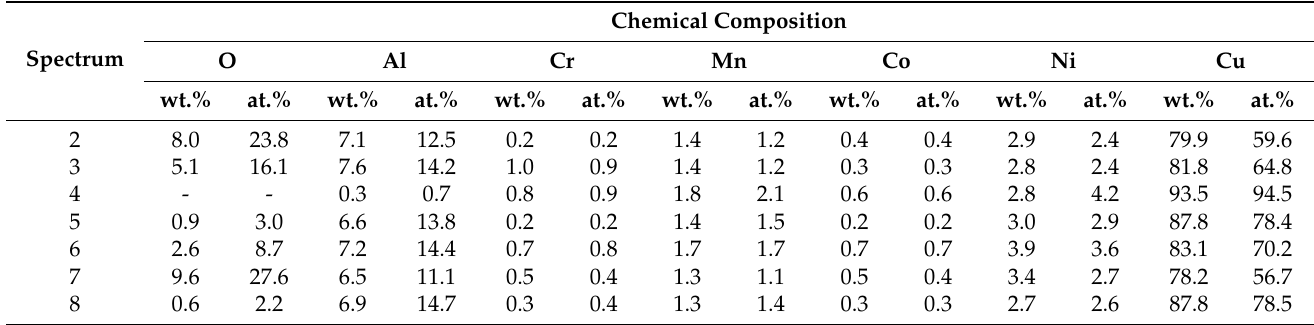
Figure 15. Wear ( a ) and coefficient of friction (CoF) ( b ) vs. normal load dependencies for the composite alloy samples. Table 4. EDS element concentrations in points indicated on the 15% Ud sample (Figure